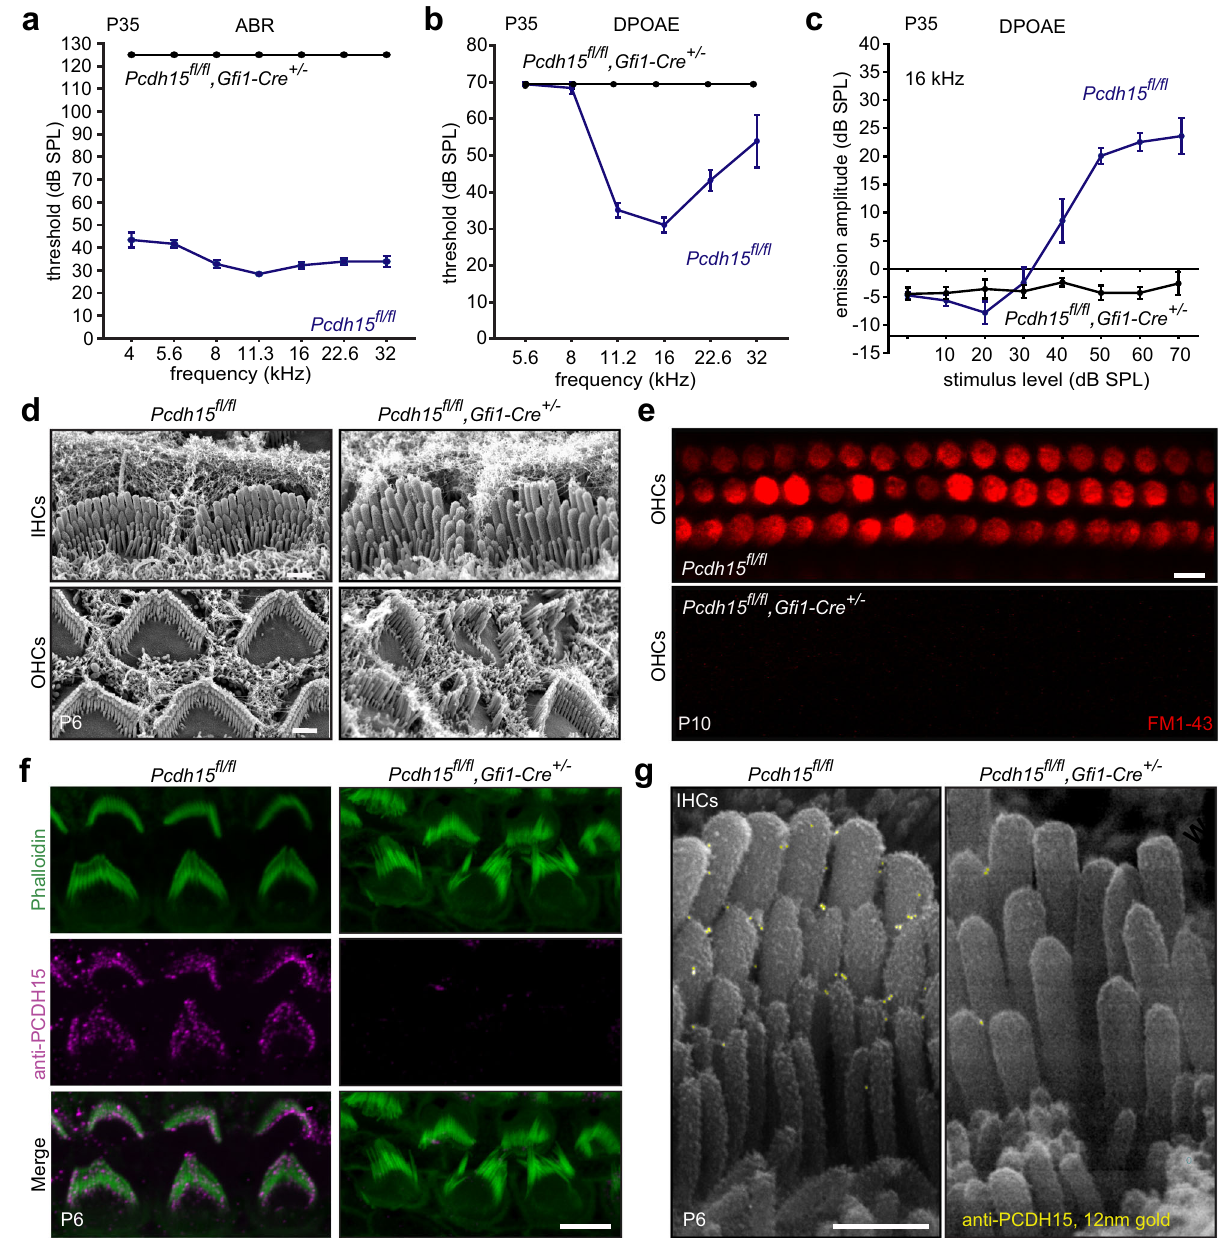
Fig. 2 | G fi 1-C re conditional Pcdh15 knockout mouse cochleas show severe functional and morphological changes. a Average auditory brainstem response (ABR)thresholds asa function of frequencyin P35mice. Pcdh15 fl / fl ,G fi 1-Cre +/ − ( n =6) mice showed a profound hearing loss at P35 relative to Pcdh15 fl / fl control mice ( n =9). b Knockout mice hadno distortion-productotoacoustic emission (DPOAE) responses ( n =6) compared to Pcdh15 fl / fl hearing control mice ( n =9). c DPOAE emission amplitude at 16kHz in P35 Pcdh15 fl / fl ,G fi 1-Cre +/ − ( n =5) was signi fi cantly reduced compared to the control mice ( n =4). d Representative scanning electron micrographs taken from P6 mice show disorganized inner hair cells (IHCs) (upper row) and outer hair cells (OHCs) (lower row) stereocilia morphology in Pcdh15 fl / fl , G fi 1-Cre +/ − haircells(right)ascomparedto Pcdh15 fl / fl controls(left). e Representative